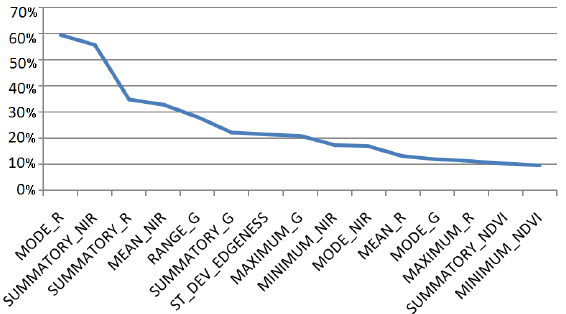
Figure 5: Relevance of features in classification of the second DMC image.